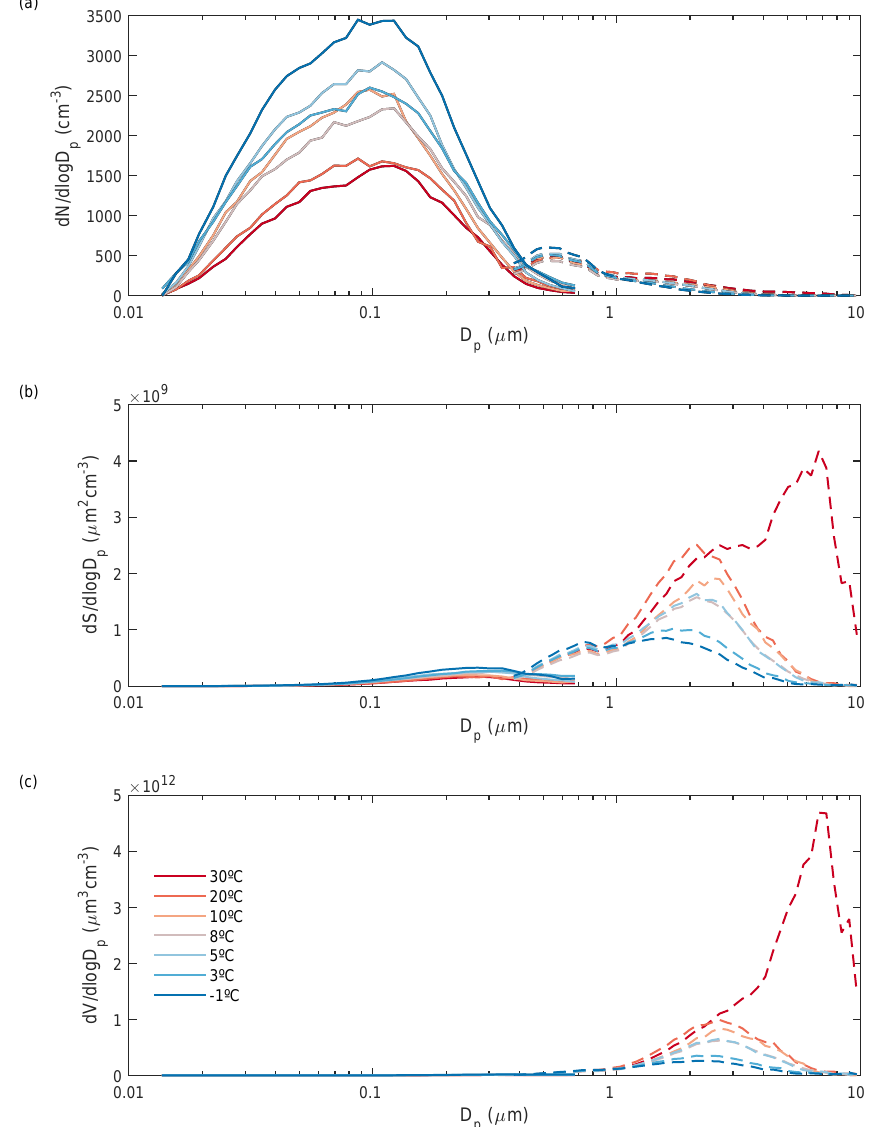
Figure 2. Mean particle (a) number size distribution, (b) surface size distribution, and (c) volume size distribution measured at different water temperatures. The solid lines represent the DMPS measurements ( D p < 0 . 7µm electrical mobility diameter), while the dashed lines show the OPSS data ( D p > 0 . 35µm optical equivalent diameter when m = 1 . 54 − 0 i